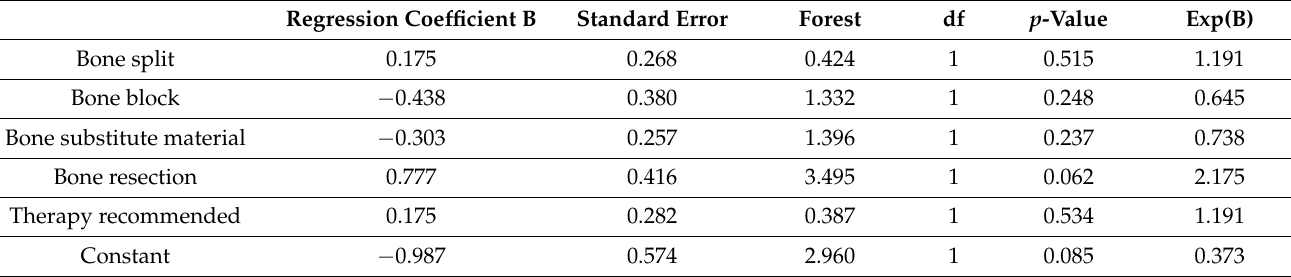
Table 5. Association between the dependent variable “specialist designation” (maxillofacial vs. oral surgeon) and the independent variables “bone split”, “bone block”, “bone substitute material”, “bone resection”, and “therapy recommended” for Case Vignette 2.